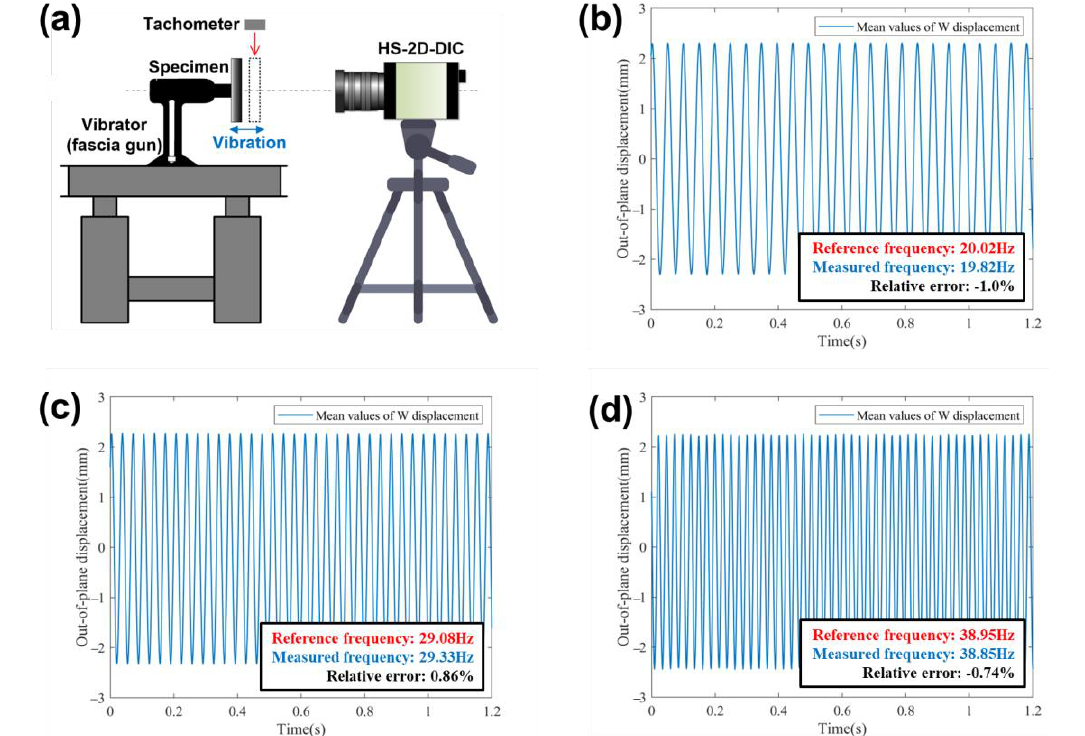
Figure 7. ( a ) Schematic of the single-frequency vibration measurement experiment and the results of the vibrational tests with reference frequencies of ( b ) 20.02 Hz ( c ) 29.08 Hz, and ( d ) 38.95